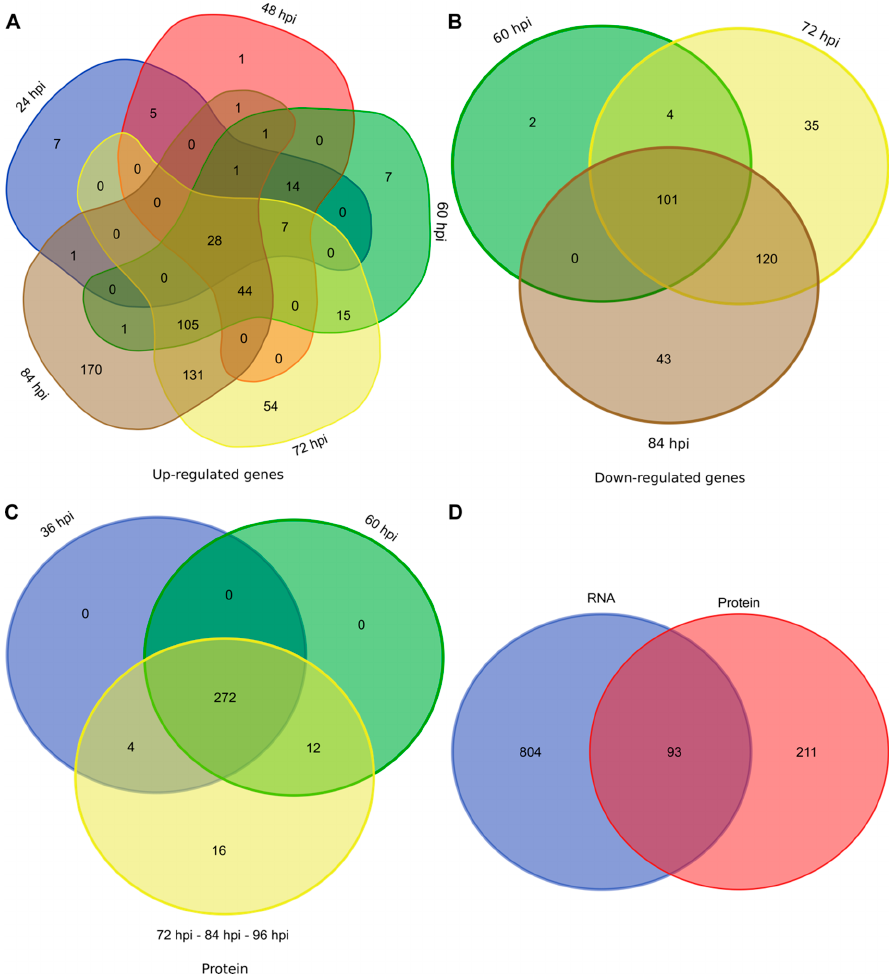
Figure 2. Venn diagram showing overlap of the 593 upregulated genes ( A ), 304 downregulated genes ( B ) and 304 QPs ( C ) across infection stages, together with the overlap of genes and proteins based on results from both transcriptomic and proteomic analysis during infectious process ( D ).